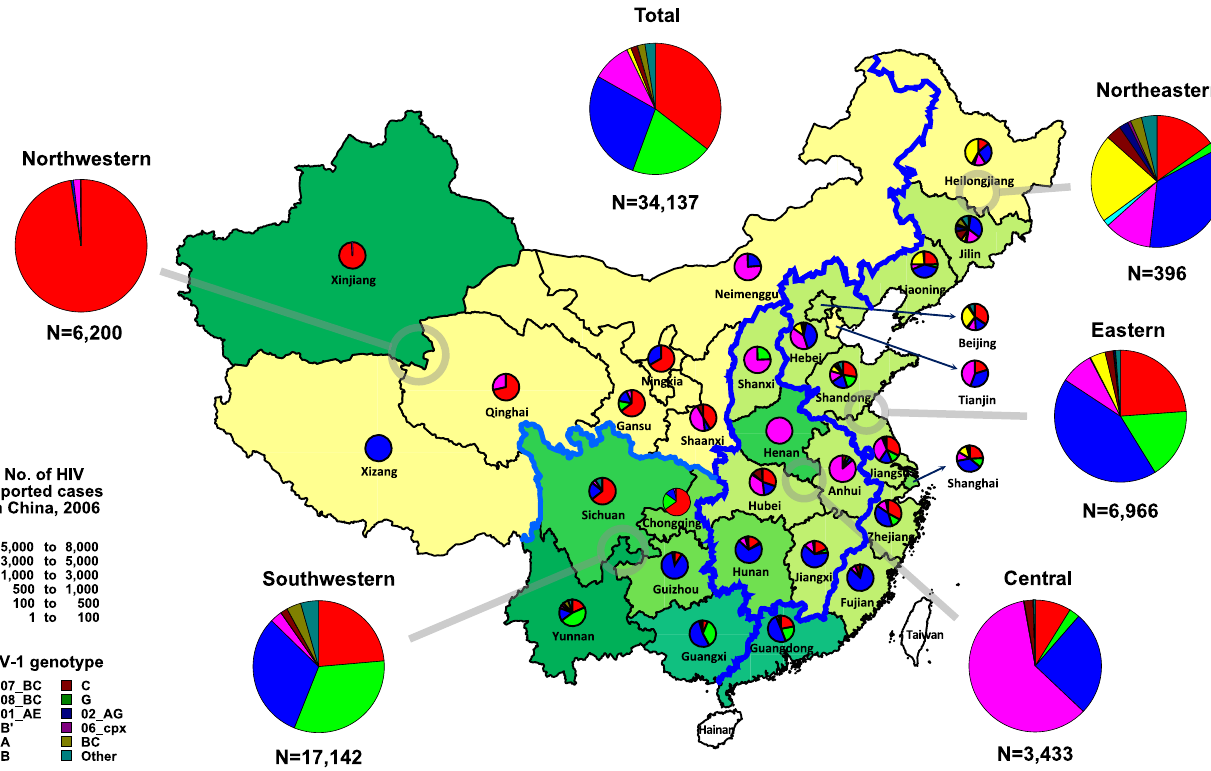
Figure 1. Estimated distribution of HIV-1 genotypes in different provinces in China. Distribution of HIV-1 genotypes in each provinces across mainland China (n=30), except Hainan, was illustrated based on the dataset tabulated in Table S2.